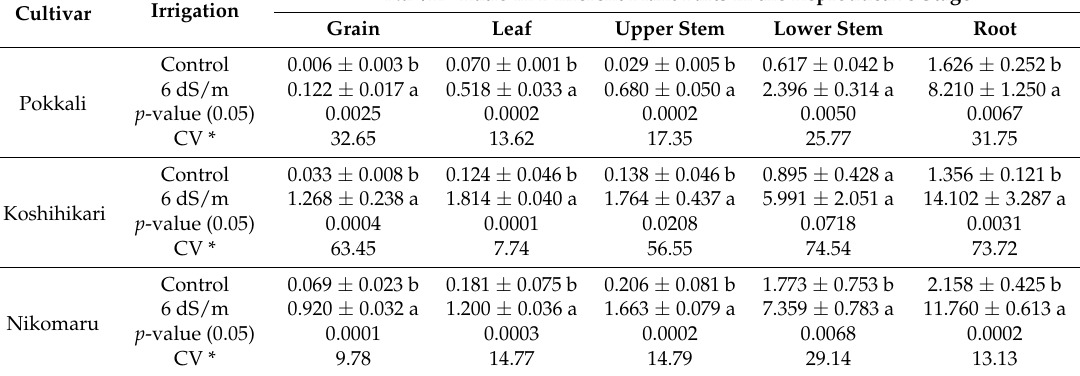
Table 2. Na + /K + ratio in different parts of the rice plant body under control and 6 dS/m saline irrigation in the reproductive stage. Means ± standard error followed by the different letters in the same column are significantly different at p ≤ 0.05. * Coefficient of